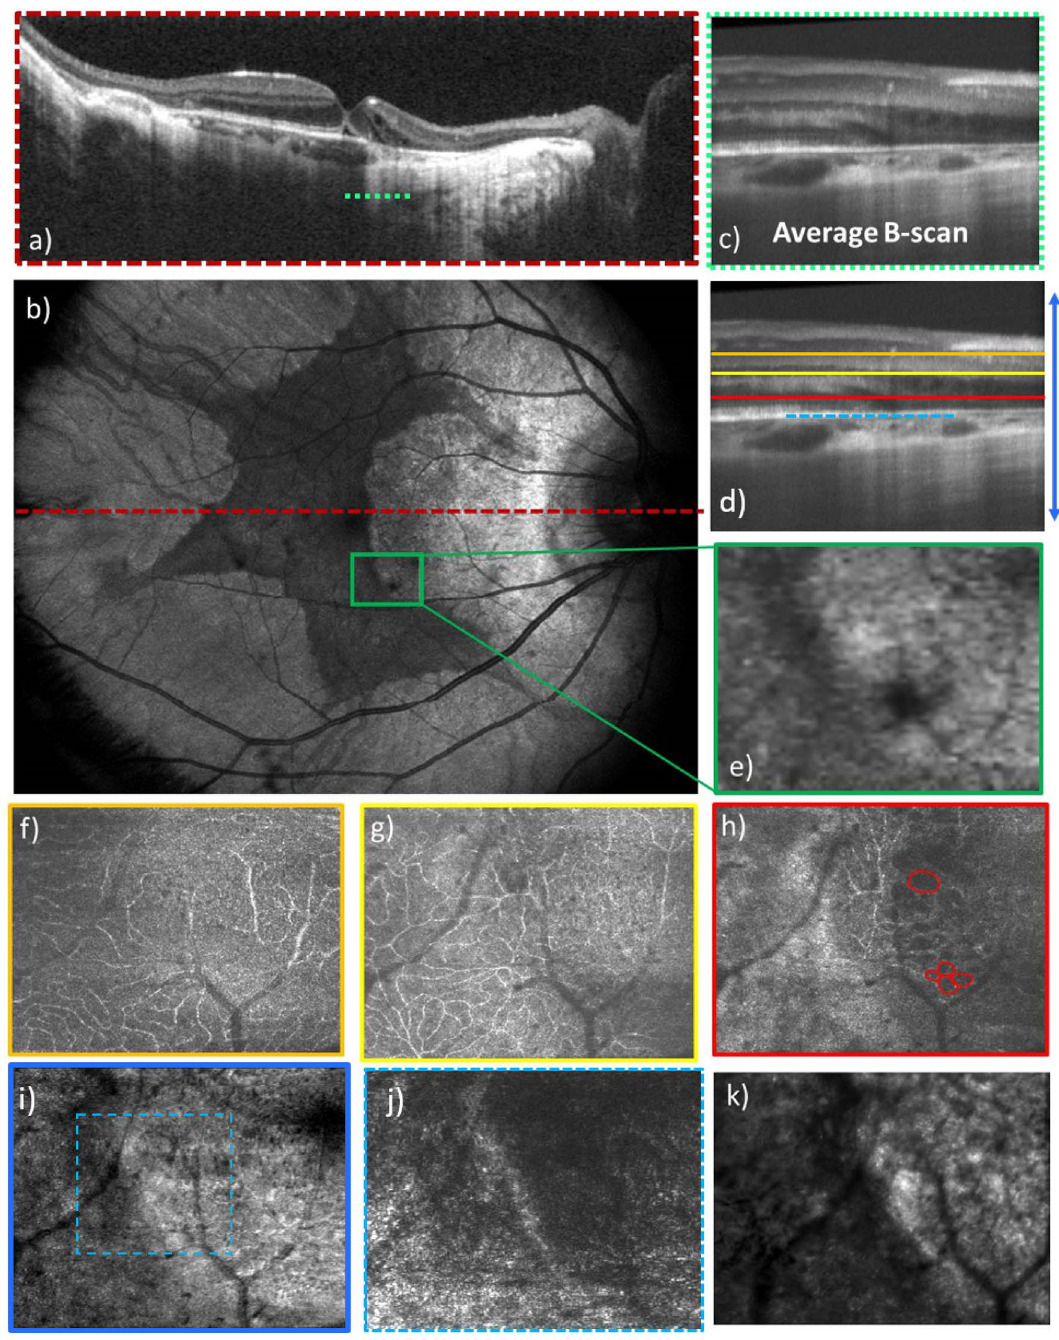
Figure 7. AO-OCT and AO-SLO images of a patient with choroideremia disease with 4° × 3° field of view along with the large field of view images. ( a ) Average OCT large field of view B-scan in log scale, ( b ) OCT large field of view en-face projection image with 40° × 30° field of view, ( c ) average AO-OCT B-scan in log scale, ( d ) location of corresponding layers displayed in the en-face images, ( e ) large field of view en-face projection image with zoom at the location imaged with AO-OCT, ( f ) mid capillary plexus layer, ( g ) deep capillary plexus layer, ( h ) outer nuclear layer with red circles indicating the microcysts, ( i ) entire depth projection image, ( j ) depth projection over photoreceptor and RPE layers at the 2° × 2° field marked in ( j , k ) AO-SLO image of the corresponding